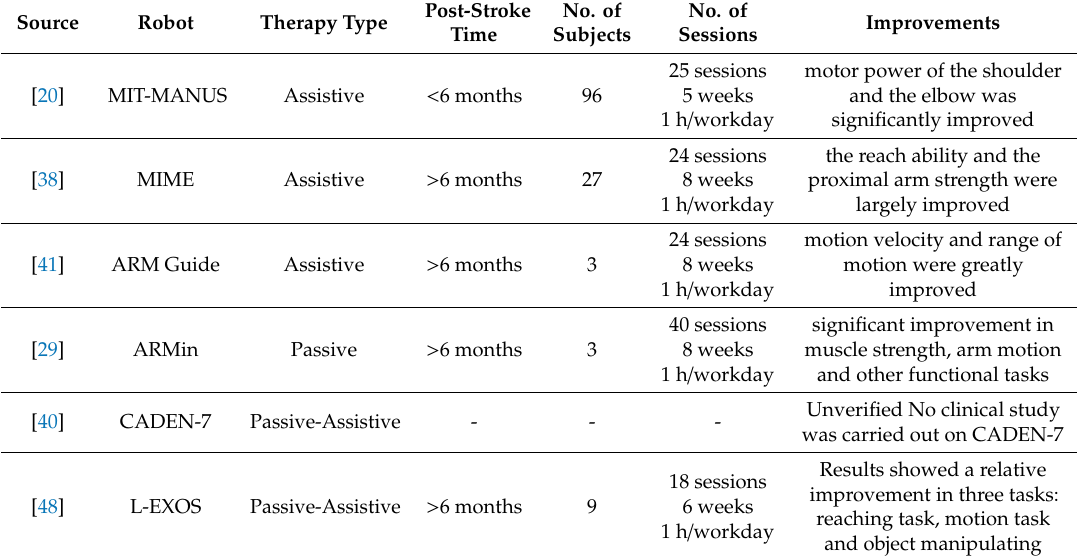
Table 5. Clinical results of the rehabilitation